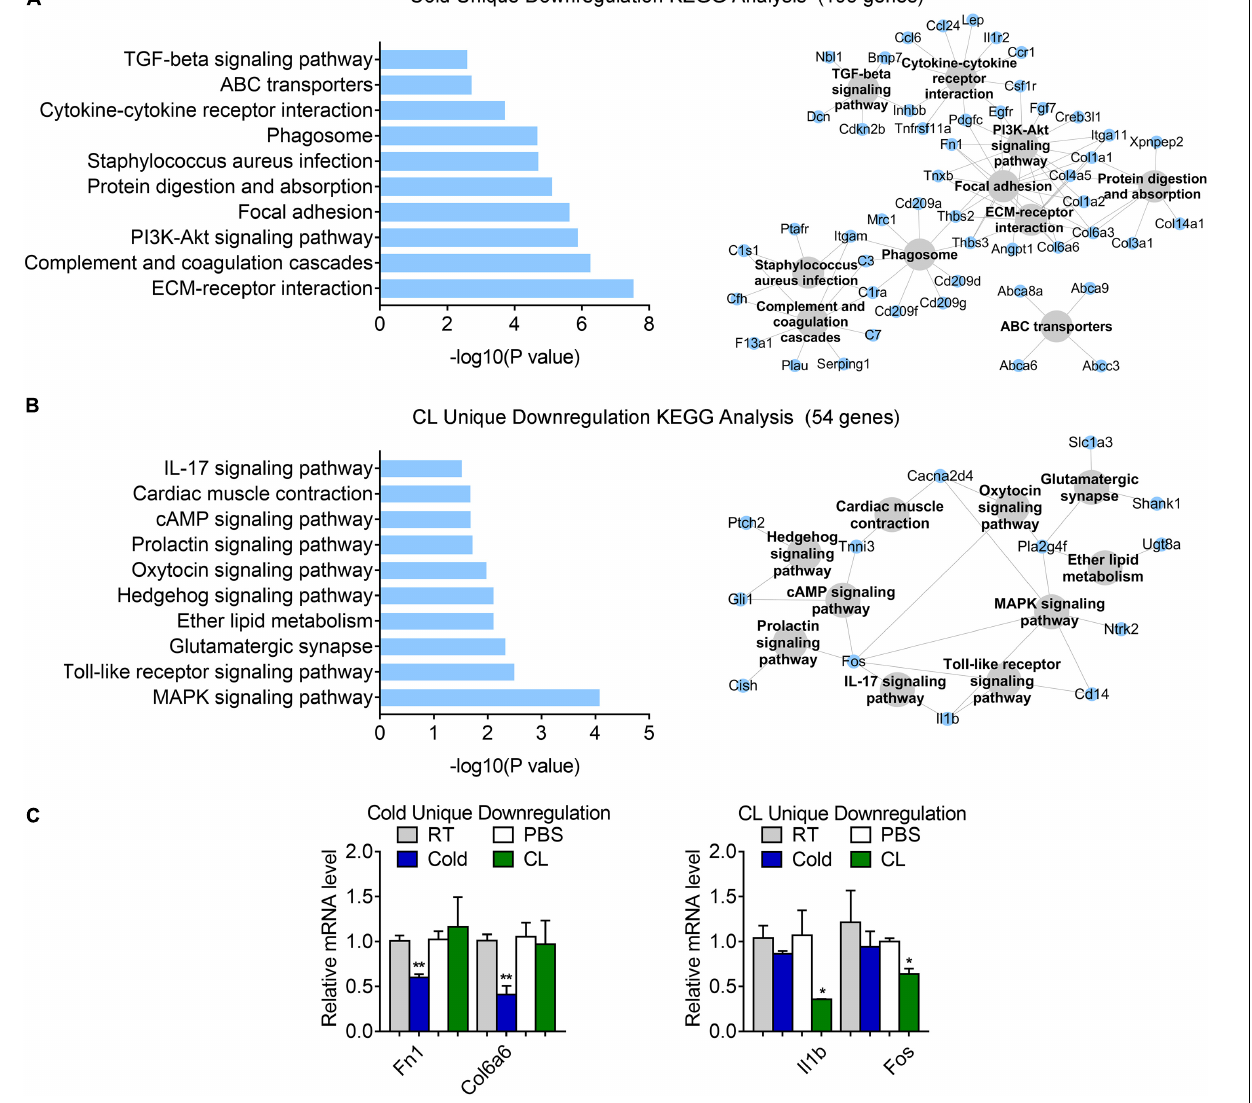
FIGURE 8 | Analysis of uniquely downregulated gene programs of cold exposure and CL administration. (A,B) KEGG analysis and pathway-gene network for uniquely downregulated DEGs [ (A) 195 genes in cold datasets, (B) 54 genes in CL datasets]. (C) mRNA levels of top ranked genes exclusively downregulated in iWAT of mice under cold exposure or CL administration. N = 6 per group. Data are presented as mean ± SEM and * P < 0.05, ** P < 0.01 compared to control